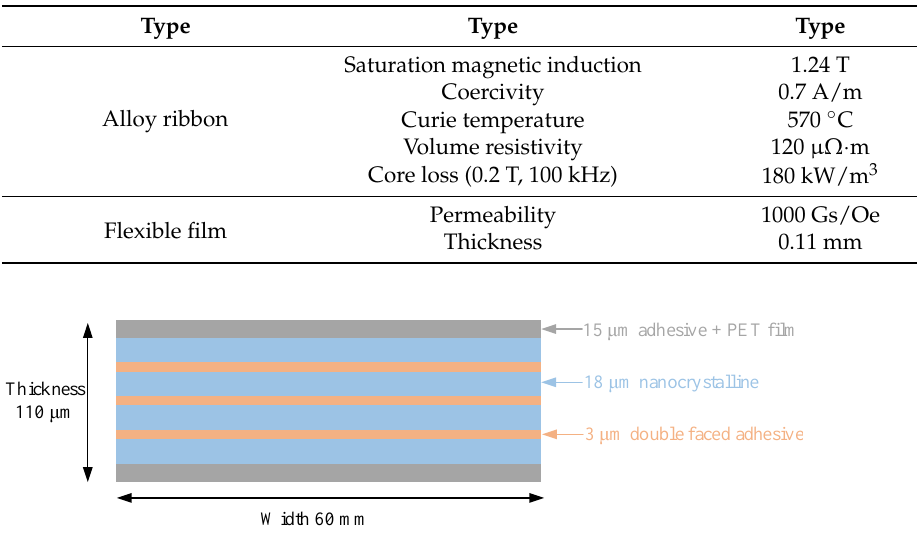
Table 2. Parameters of nanocrystalline alloy.